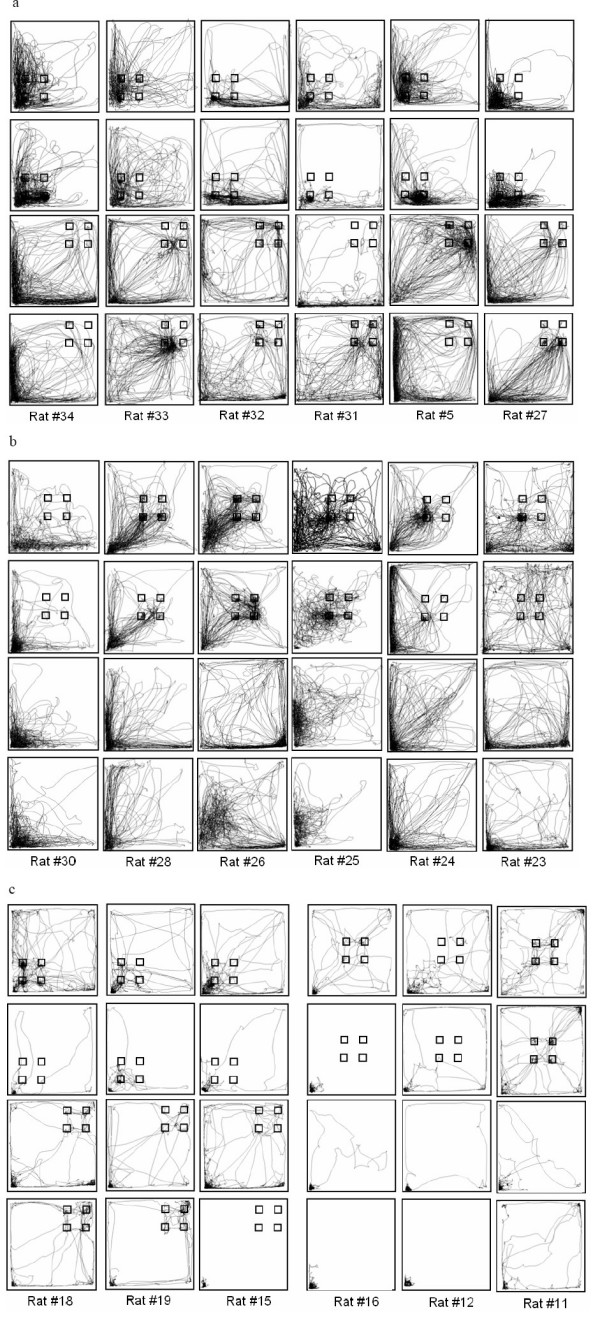
Routes of progression are shown for six quinpirole-treated rats that first underwent two-wall shift, and then translocation (a), six quinpirole-treated rats that first underwent four-wall shift and then removal (b), and six saline-treated rats (c) of which three rats underwent the procedure shown in a) and another three rats underwent the procedure shown in b). Each column depicts routes of progression in one individual rat during the two session under one test setting, and then two sessions under the subsequent test session. (Note that each rat was tested twice in each setting, of which both are depicted above).